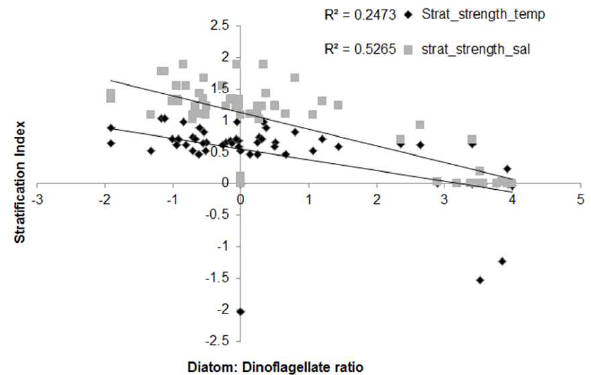
Fig. 8. The relationship between stratification index and diatom to dinoflagellate ratio. A value of zero in the stratification index means no stratification at all. Positive values show successively stronger stratification. Negative values indicate inverse stratification: dark marks = temperature stratification, grey marks = salinity stratifi- cation, n =